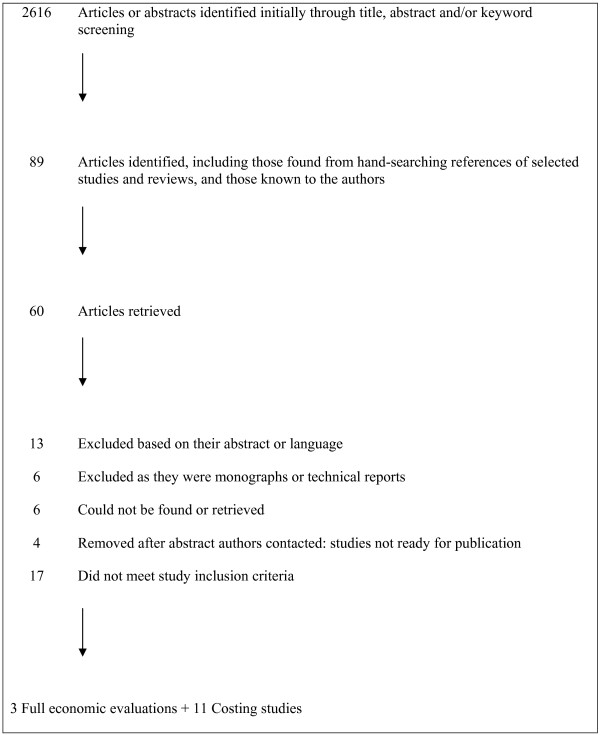
QUORUM flow chart.